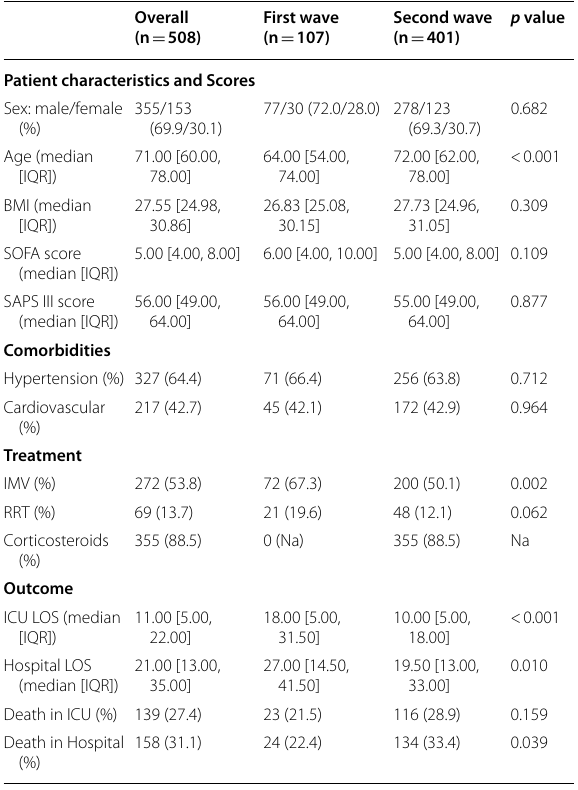
Table 1: Comparison between critically ill COVID-19 patients of the first and second wave